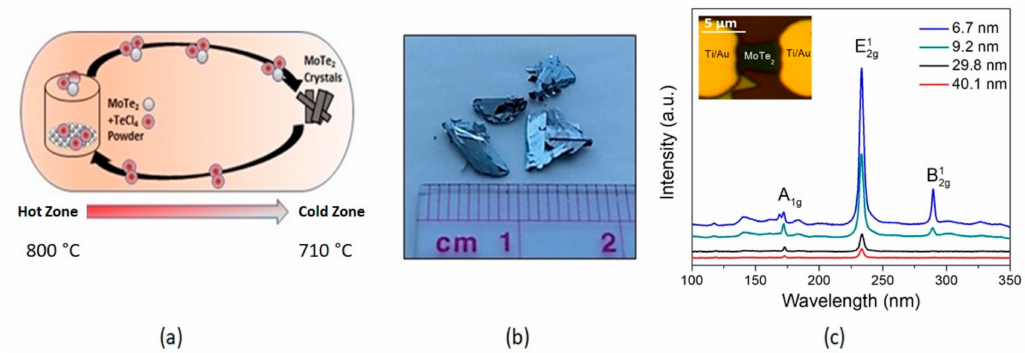
Figure 1. ( a ) Schematic diagram of the two-zone electric furnace used for the growth of 2H-MoTe 2 crystal using TeCl 4 as transport agent; ( b ) As-synthesized bulk of MoTe 2 crystals after growth; ( c ) Raman spectra of MoTe 2 flakes of di ff erent thickness exfoliated from bulk MoTe 2 single crystals grown by chemical vapor transport (CVT) with TeCl 4 transport agent. Inset shows plane-view optical image of FET device with a 4.6 nm thick